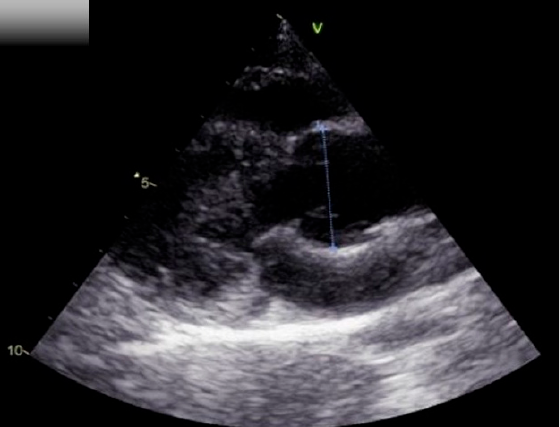
ms. The calculated duration of the QT interval corrected for heart rate by Bazzett’s formula is 470